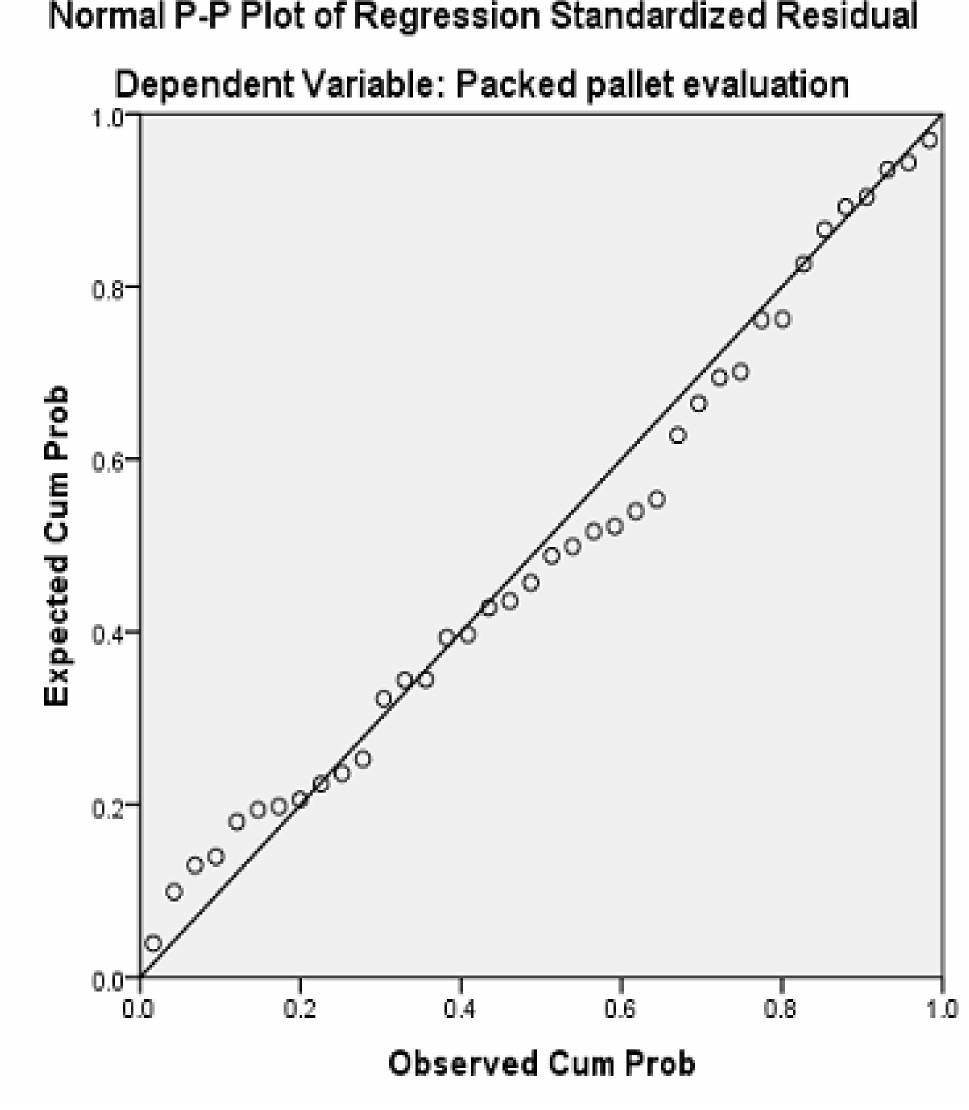
Figure 3. Predicted probability plot (for 9